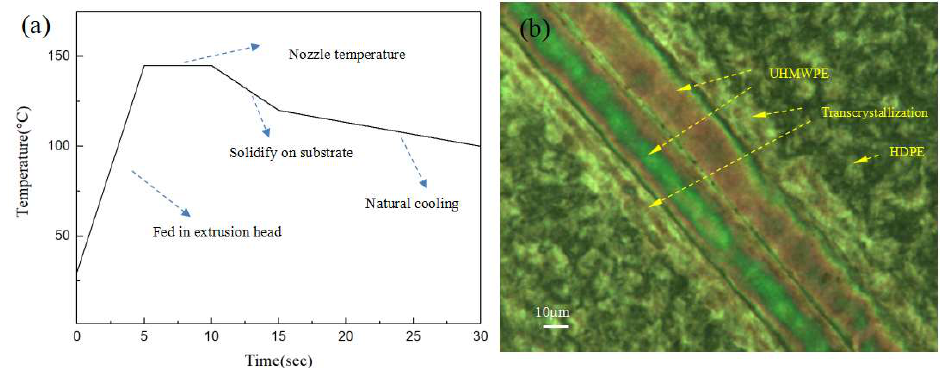
Figure 10. ( a ) Simulation of the 3D-printing temperature field at a printing speed of 120 mm/min. ( b ) POM images of two UHMWPE fiber–HDPE composite specimens.